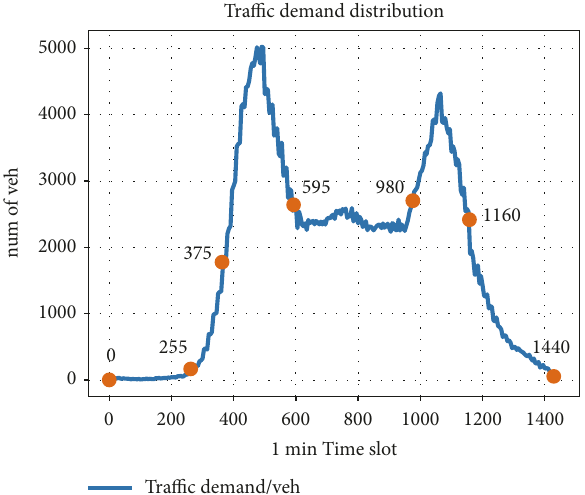
Figure 10: Subinterval traffic demand